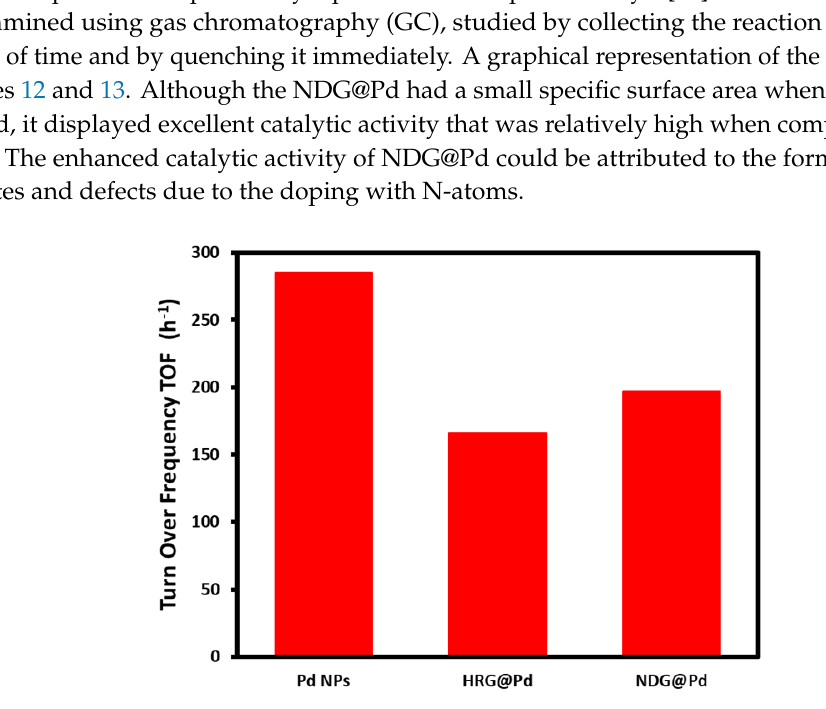
Figure 11. Graphical illustration of comparative turnover frequency (TOF) values.